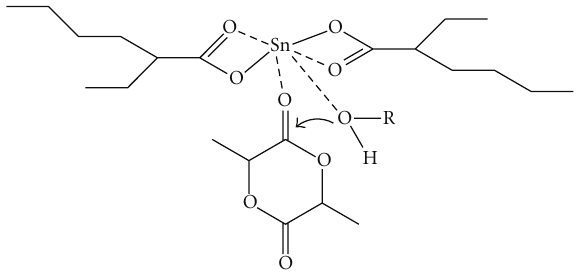
Scheme 11: Activated monomer mechanism for ring-opening polymerization of lactones.